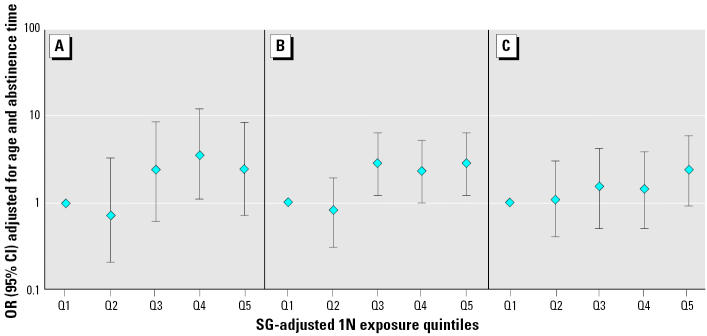
Adjusted ORs and 95% CIs for below-reference semen parameters by increasing quintiles of 1N for (A) sperm concentration (p-value for trend = 0.02), (B) motility (p-value for trend = 0.002), and (C) morphology (p-value for trend = 0.09). The quintiles of SG-adjusted 1N (μg/L) are as follows: Q1 (low), < LOD to 1.50; Q2, 1.50–2.67; Q3, 2.67–3.73; Q4, 3.73–5.86; Q5 (high), 5.86–159.7.